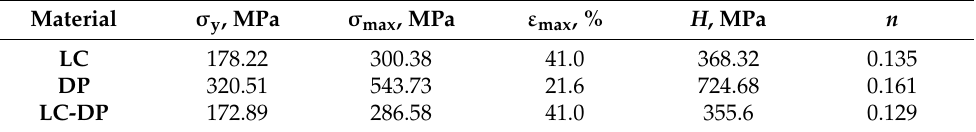
Table 3. Tensile mechanical properties of the base materials and LC–DP dissimilar